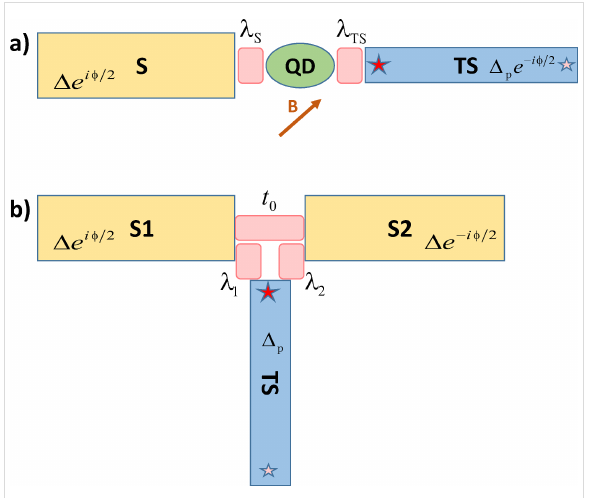
Figure 1: Schematic setups studied in this paper. a) S–QD–TS geom- etry: S denotes a conventional s -wave BCS superconductor with order